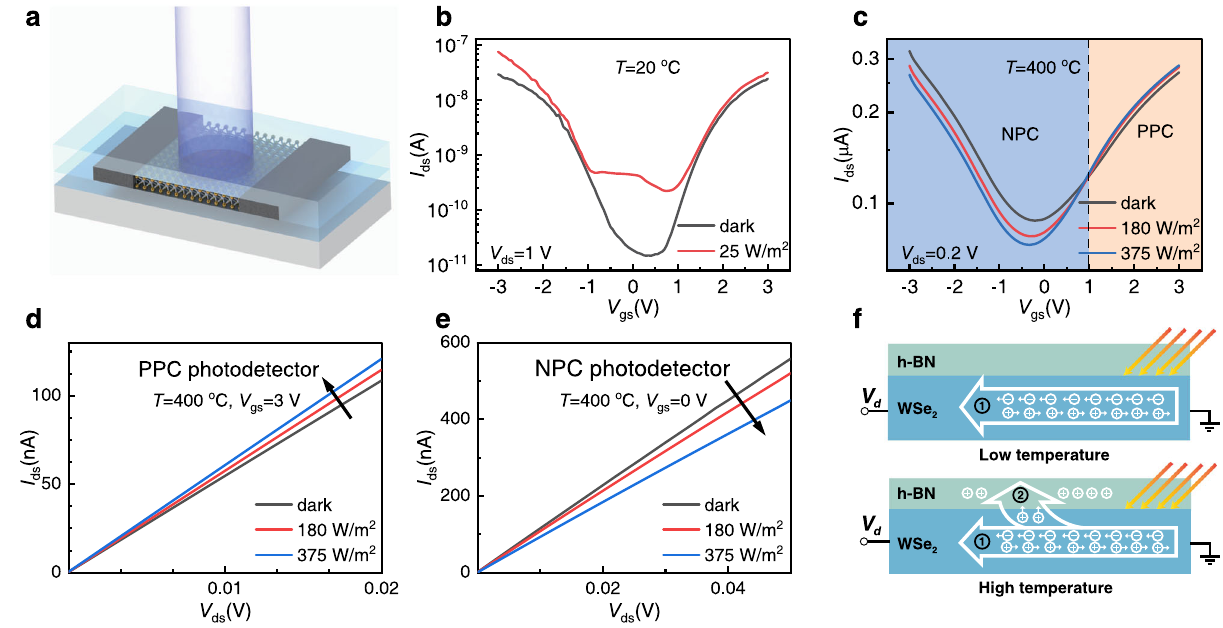
V gs =0V. f Schematical views of optical sensing mechanism. At relatively low tem- perature, photoexcited electron-hole pairs are responsible for photocurrent (pro- cess 1). At high temperature, charge carriers have more chance to enter h-BN. Photogenerated holes trapped by the defect states in h-BN act as an equivalent positive gate bias (process